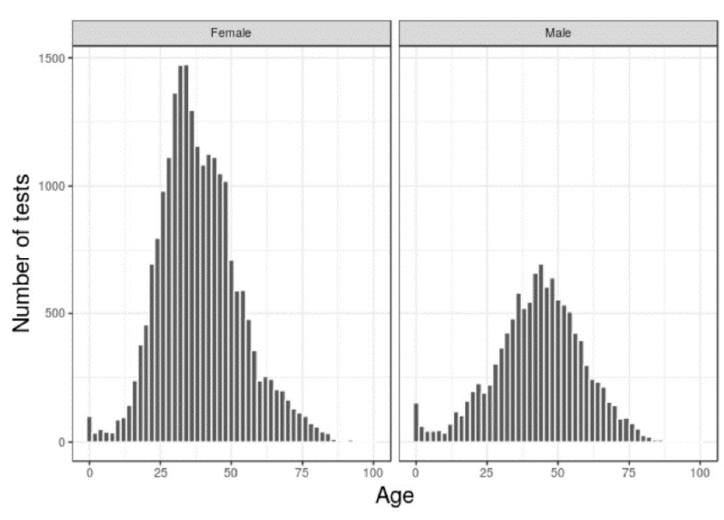
Figure 2. Genetic tests performed by gender and age (1998–2017).